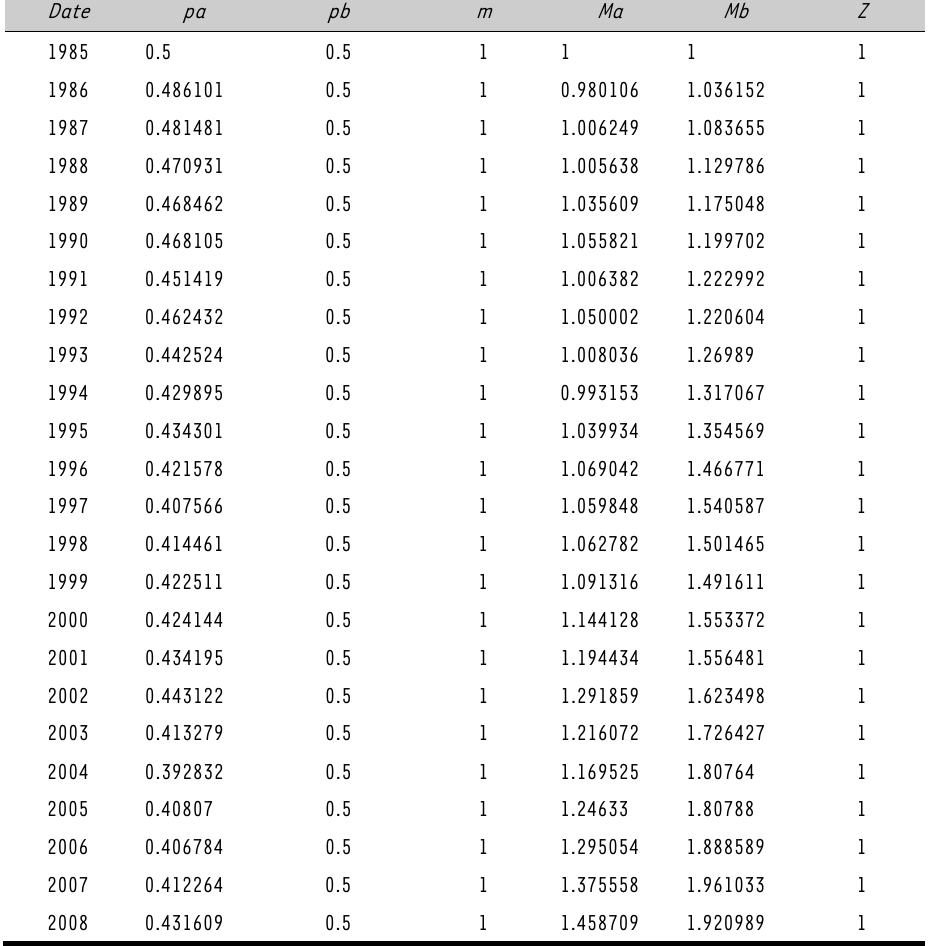
TABLE 1: Data used in the Conflict Success Function (CSF), Ratio